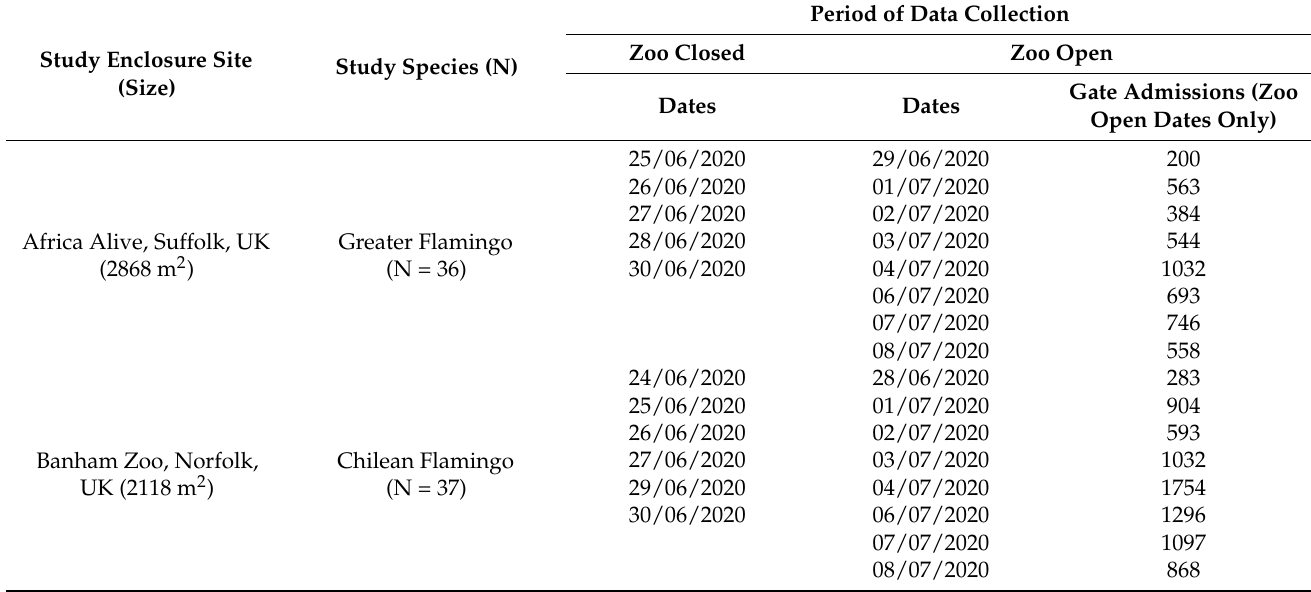
Table 1. Details of the data collection schedule for each flamingo species and total number of visitors on site (Gate